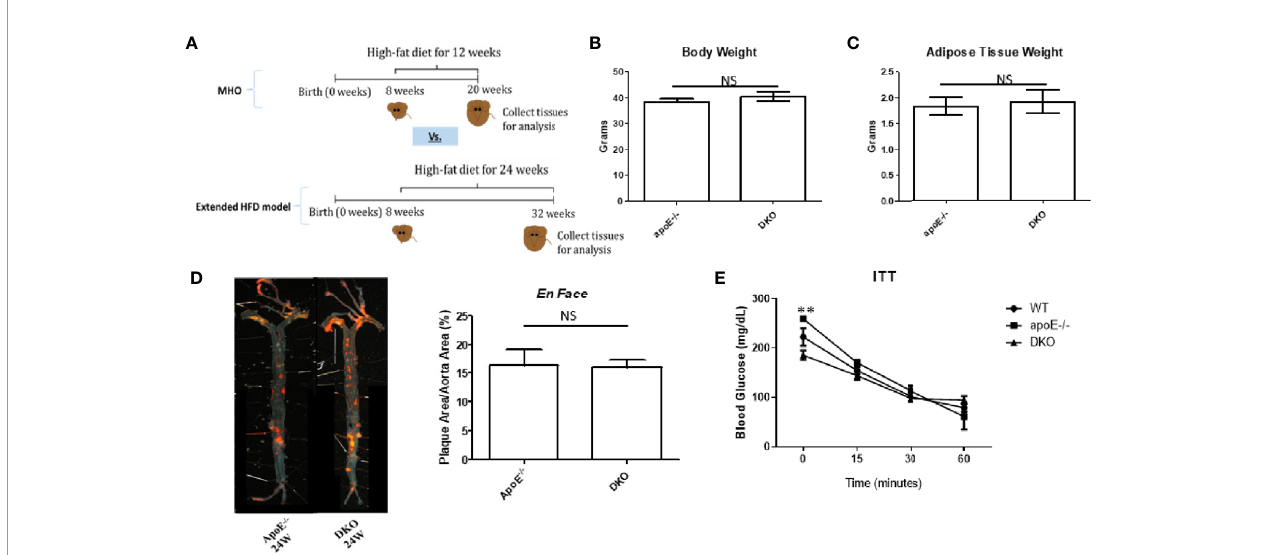
FIGURE 2 | miR155-/-/ApoE-/- double gene knock-out (DKO) mice exhibit resurgent atherosclerosis following extended high fat diet (HFD) feeding. (A) Extended HFD experiment design. DKO mice at MHO stage are fed on HFD for 12 weeks beginning at 8 weeks. DKO mice at extended HFD stage (when MUO develops) are fed on HFD for 24 weeks beginning at 8 weeks. (B) Total body weight (grams); ApoE-/- (n=15), DKO (n=12). (C) Gonadal WAT (grams); apoE -/- (n=10), DKO (n=11). (D) En Face analysis of whole aortas; male ApoE -/- (n=5); male DKO (n=8). Previous data showed that aortas from 12 weeks of HFD-fed DKO mice compared with ApoE -/- mice had signi fi cantly less plaque deposition (PMID: 27856635). Here, following 24 weeks of HFD, both ApoE -/- and DKO mice have signi fi cant plaque deposition. (E) Insulin Tolerance Test (ITT); WT (n=3), ApoE -/- (n=2), DKO (n=3). ** p <0.01. NS, not signi fi